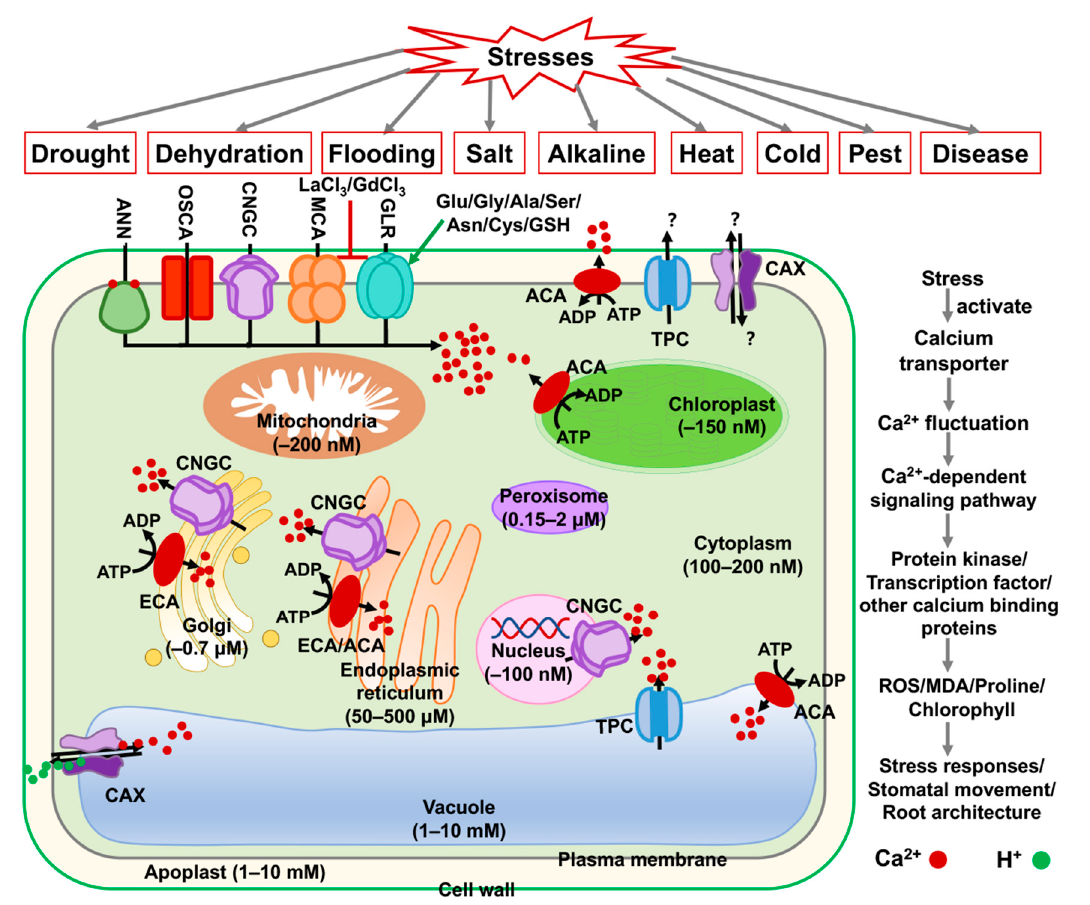
Figure 10. A summarized working model reflecting diverse soybean Ca 2+ transporters and Ca 2+ concentrations in different cellular compartments of a soybean cell. The various Ca 2+ concentration in different organelles is mainly regulated by two efflux transporters (Ca 2+ -ATPase (ACA and ECA), and Ca 2+ /H + antiporter (CaCA)), and six influx transporters (cyclic nucleotide-gated ion channel (CNGC), two-pore cation channel (TPC), glutamate receptor-like protein (GLR), hyperosmolality-gated calcium-permeable channel (OSCA), mid1-complementing activity protein (MCA), and annexins (ANNs)). The red dot is represented Ca 2+ , and the green dot is represented H + . GdCl 3 and LaCl 3 are inhibitors of GLR and MCA. Glu, Gly, Ala, Ser, Asn, Cys, and GSH are amino acid agonists of GLR.